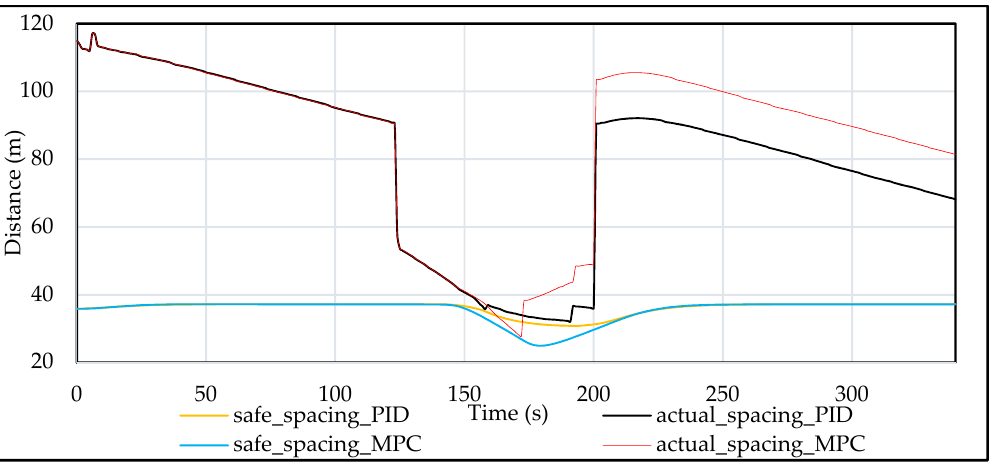
Figure 14. Spacing response in scenario 2. Table 3. Emissions results in Scenario 2.